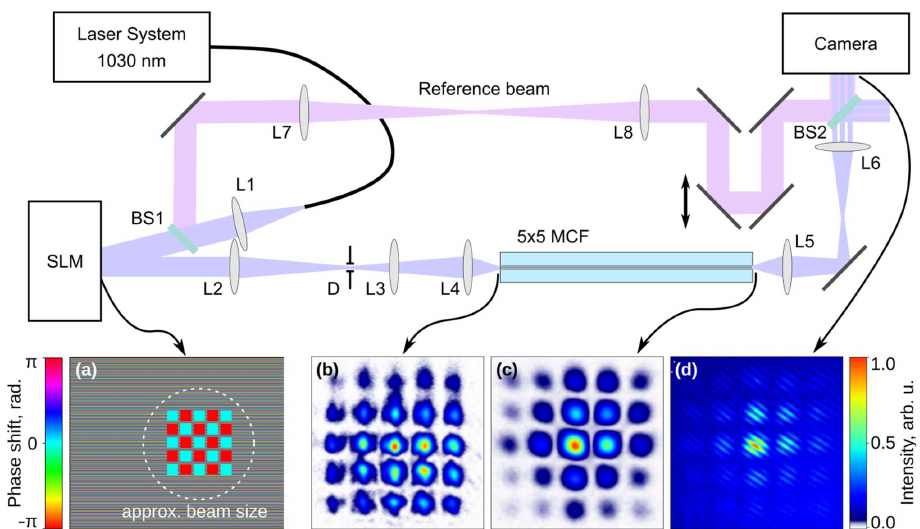
Figure 3. Schematic of experimental setup for studying supermodes propagation in MCF. L1–L8—lenses; D—a diaphragm; BS1, BS2—50/50 beamsplitters. Insets: ( a ) phase mask on the SLM; ( b ) intensity distribution image at the input face of the MCF; ( c ) intensity distribution image at the output face of the MCF; ( d ) interference picture when group delays of the reference beam and the out-of-phase supermode are matched. All insets correspond to the out-of-phase supermode excitation.